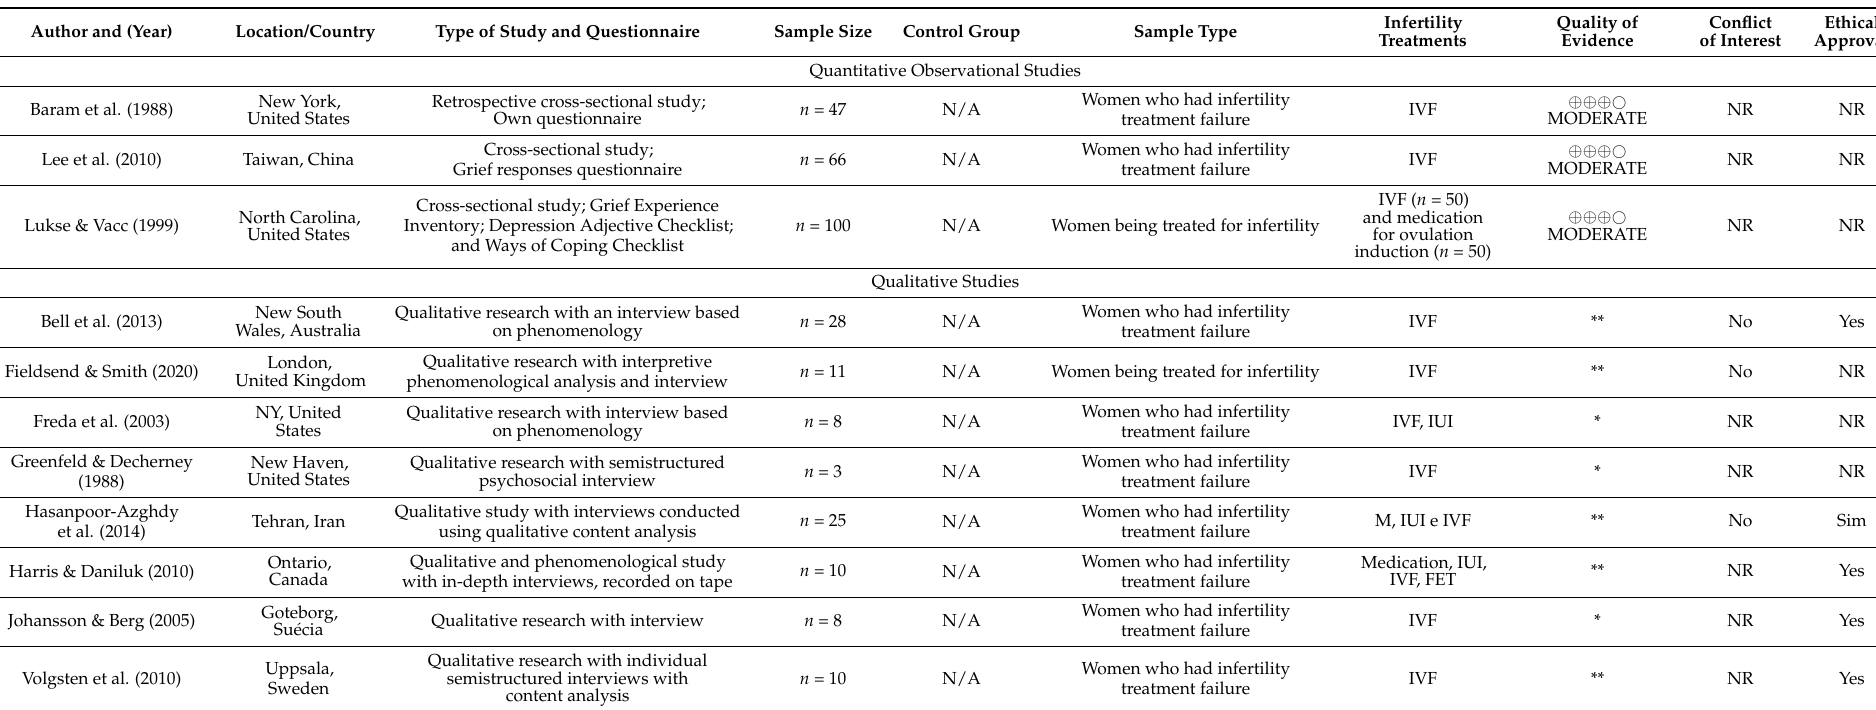
Table 1. Characteristics and quality assessment of included